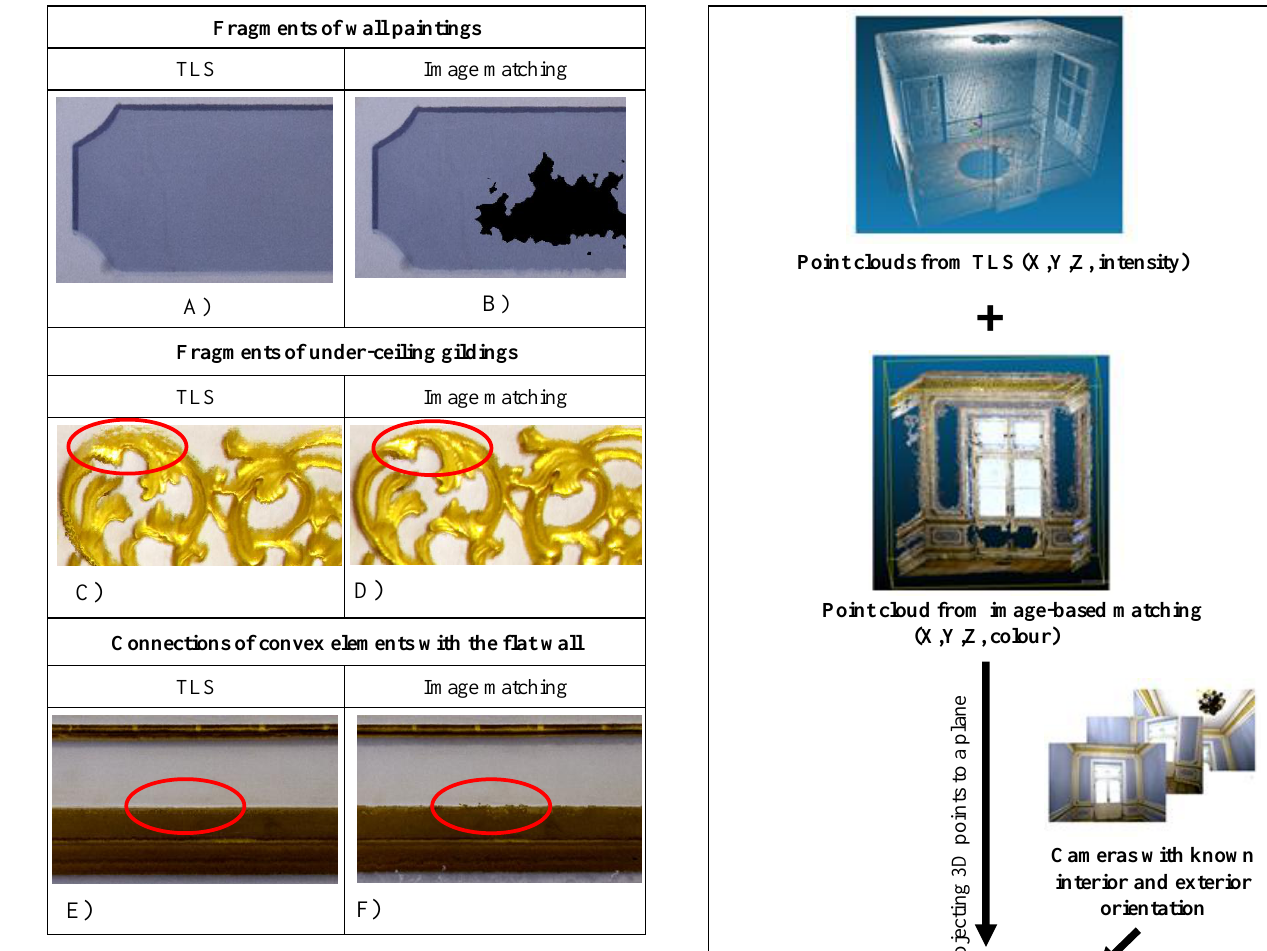
Figure 5. Comparison of examples of elements of an object on the orthoimage from TLS and from the image matching point cloud.